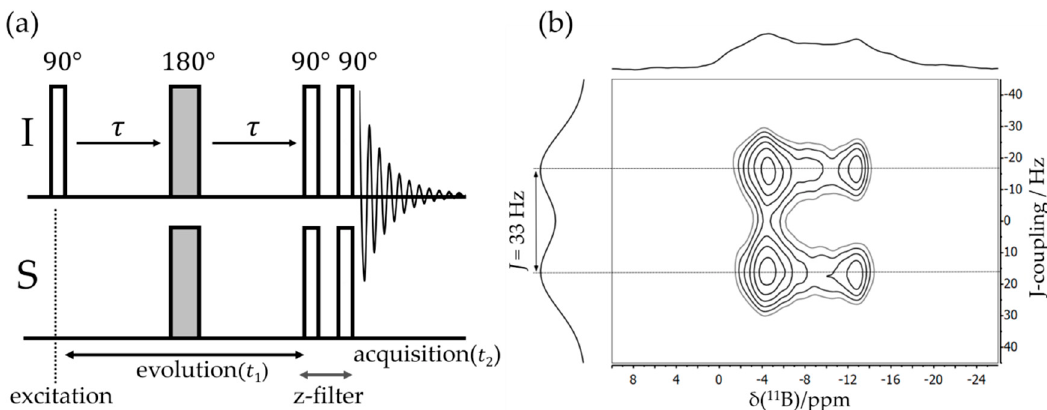
Figure 8. ( a ) Schematic representation of the pulse sequence for heteronuclear-J-resolved spectroscopy. ( b ) A typical two-dimensional (2D) 11 B{ 31 P} J-resolved MAS NMR spectrum of a B / P FLP. In the direct dimension, the horizontal projection is equal to the 11 B MAS NMR spectrum, while the spectrum obtained from Fourier transforming the data in the indirect dimension shows the doublet splitting due to J-coupling. The dipolar evolution time stated in the text is t 1/2 = τ + ½ × t 180° pulse where t 180° is the 180° pulse length.